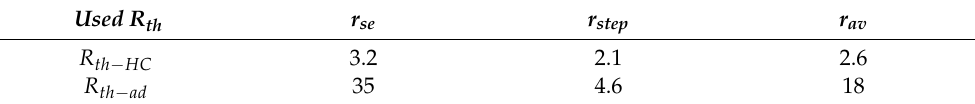
Table 1. Switching ratios based on different definitions as given in the text above. Used R